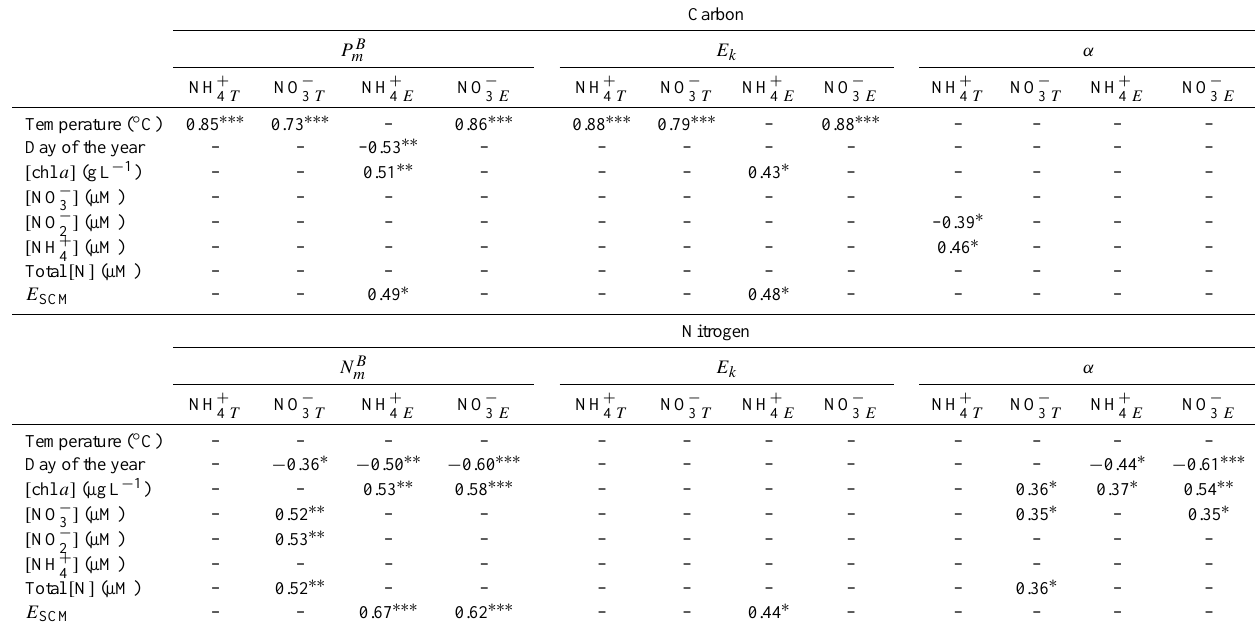
Table A1. Significant correlations between water-column variables and uptake-irradiance parameters for the data set where SCM communities were incubated with trace ( T ) or enriched ( E ) N